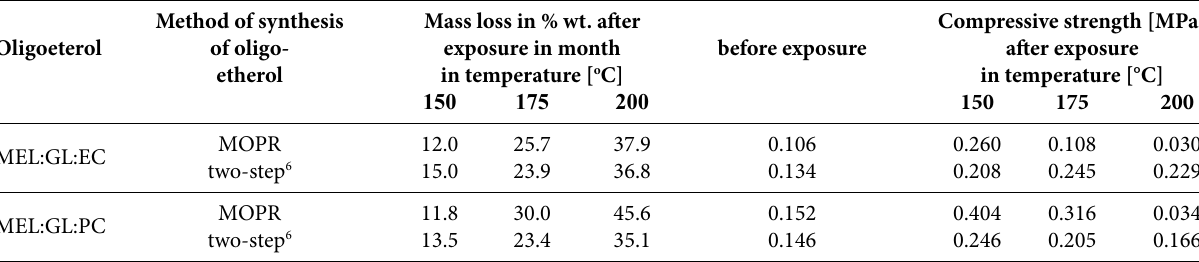
Table 6. Thermal stability and compressive strength of polyurethane foams Method of synthesis Mass loss in % wt.